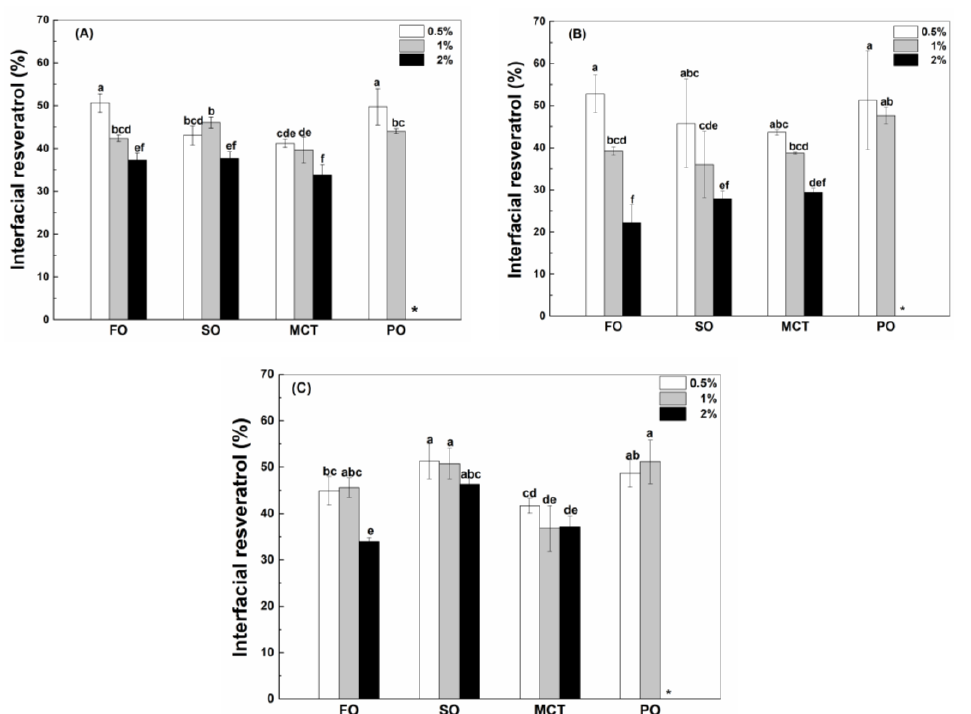
Figure 5. Interfacial percentage of resveratrol in fish oil (FO), sunflower oil (SO), MCT and pepper-mint oil (PO) emulsions stabilized by native WPI ( A ), heat-denatured WPI ( B ) and sodium caseinate ( C ) at 0.5%, 1% and 2%. Different letters mean significant differences at p < 0.05. * Peppermint oil emulsions were unstable at 2% proteins.